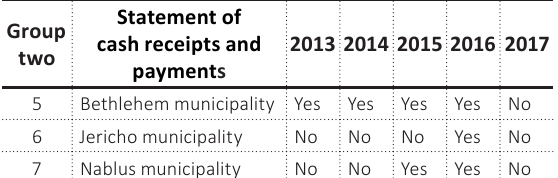
Table 10. Disclosure index of sample municipalities